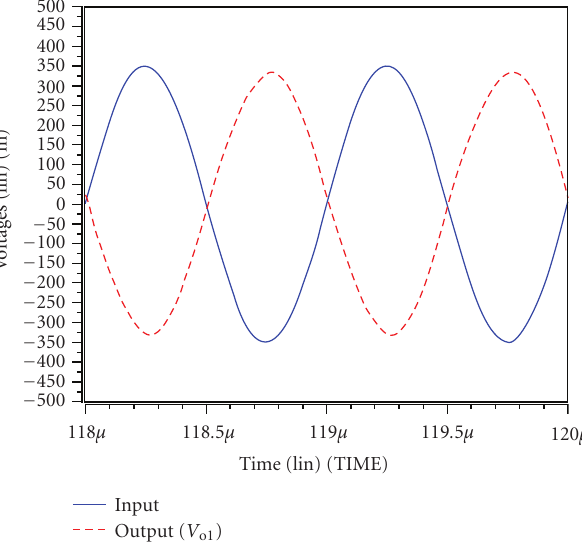
Figure 5: The input and output waveforms of inverting BP response for a 1MHz sinusoidal input of 0.7V (peak to peak).